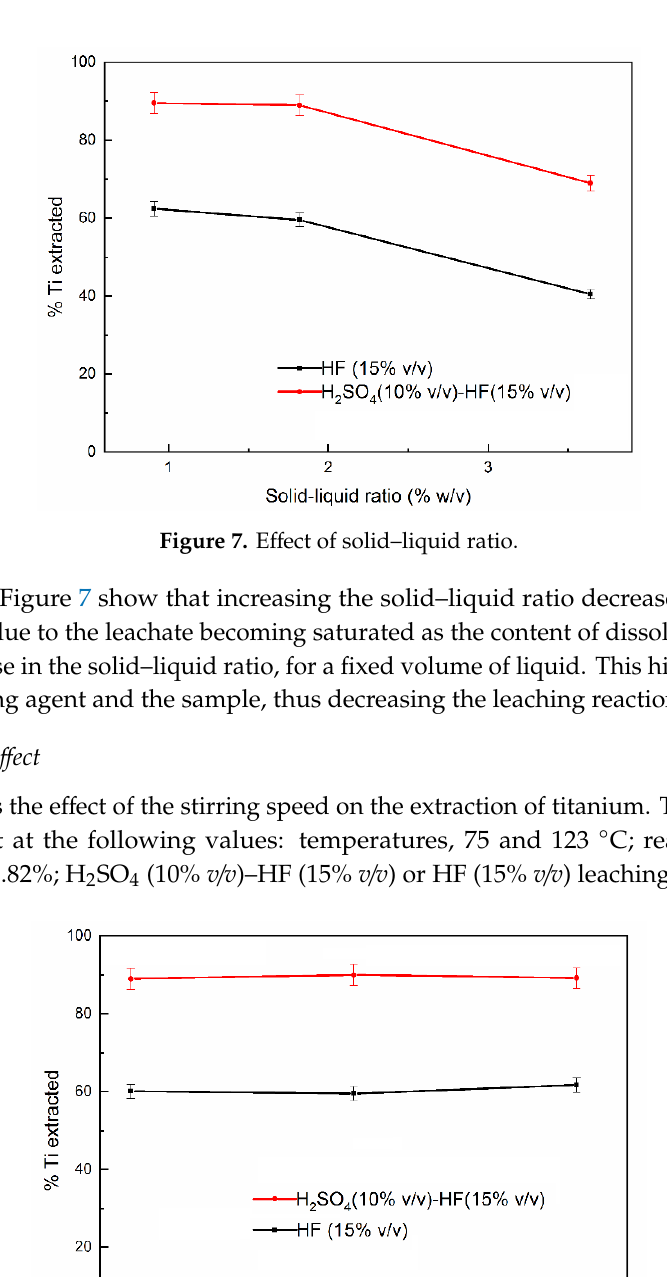
Figure 9. XRD of the residues at 123 °C: ( a ) HF; ( b ) HF (15% v/v)-H 2 SO 4 (10% v/v). In the diffractograms of Figure 9, there are no diffraction lines that fit the structures of some of the titanium compounds, which is consistent with the high titanium extraction values achieved in the leaching test. In the diffractogram of the residue from dissolution in HF medium (Figure 9a), the presence of fluorite and magnetite was observed. In the XRD obtained after treating the mineral with